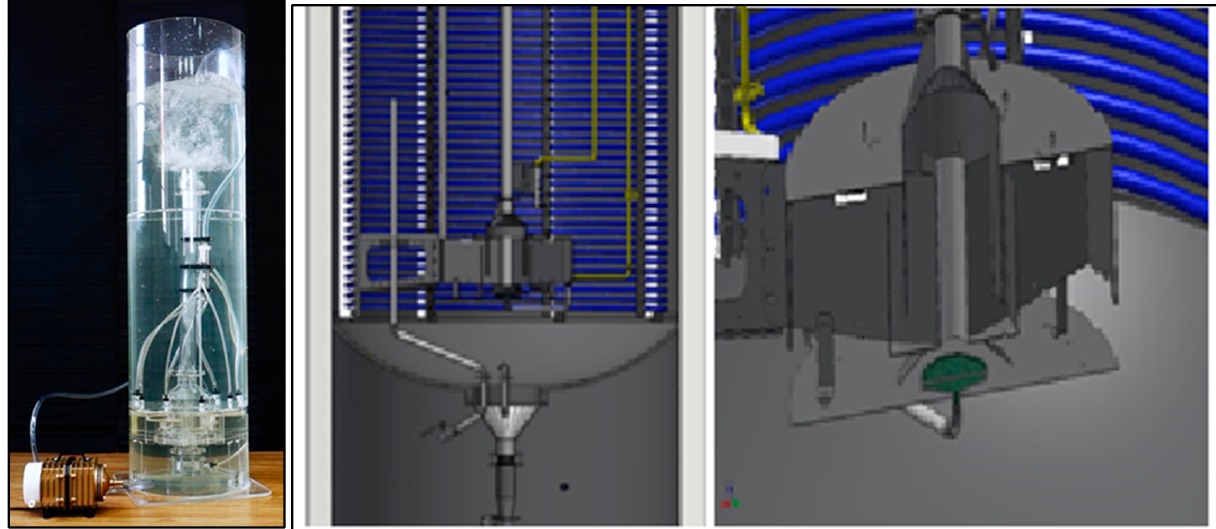
Figure 2. Hybrid pump: model ( left ) and design of the hybrid pump applied in the fermenter ( middle and right ) ([Source: image-ZOZE collection, Figure Mega-Be łż yce].